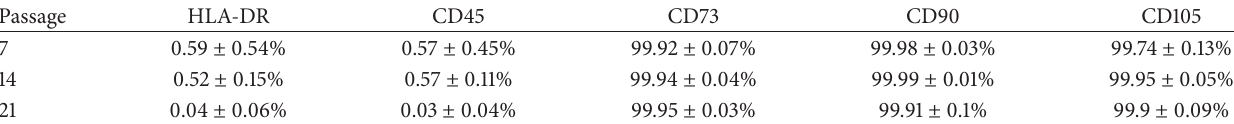
Table 2: Surface marker analysis of WJ MSCs at different passages ( 𝑛 = 3 ).